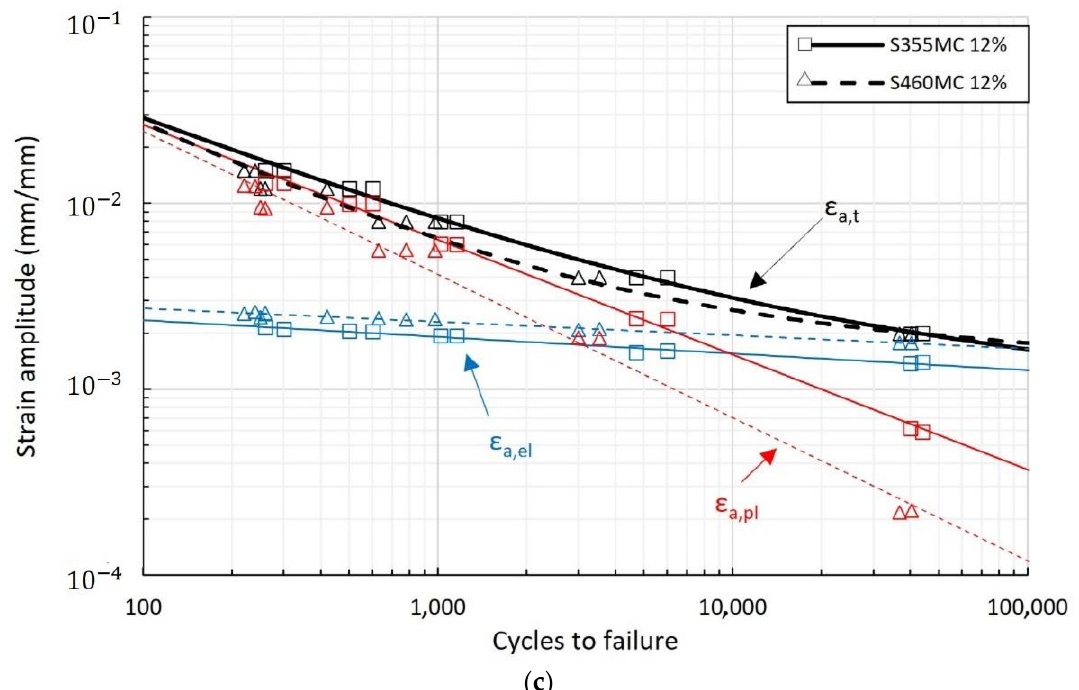
Figure 3. Strain – life curves of the S355MC and S460MC steels for ( a ) reference conditions, ( b ) 8% pre-strain, and ( c ) 12% pre-strain.